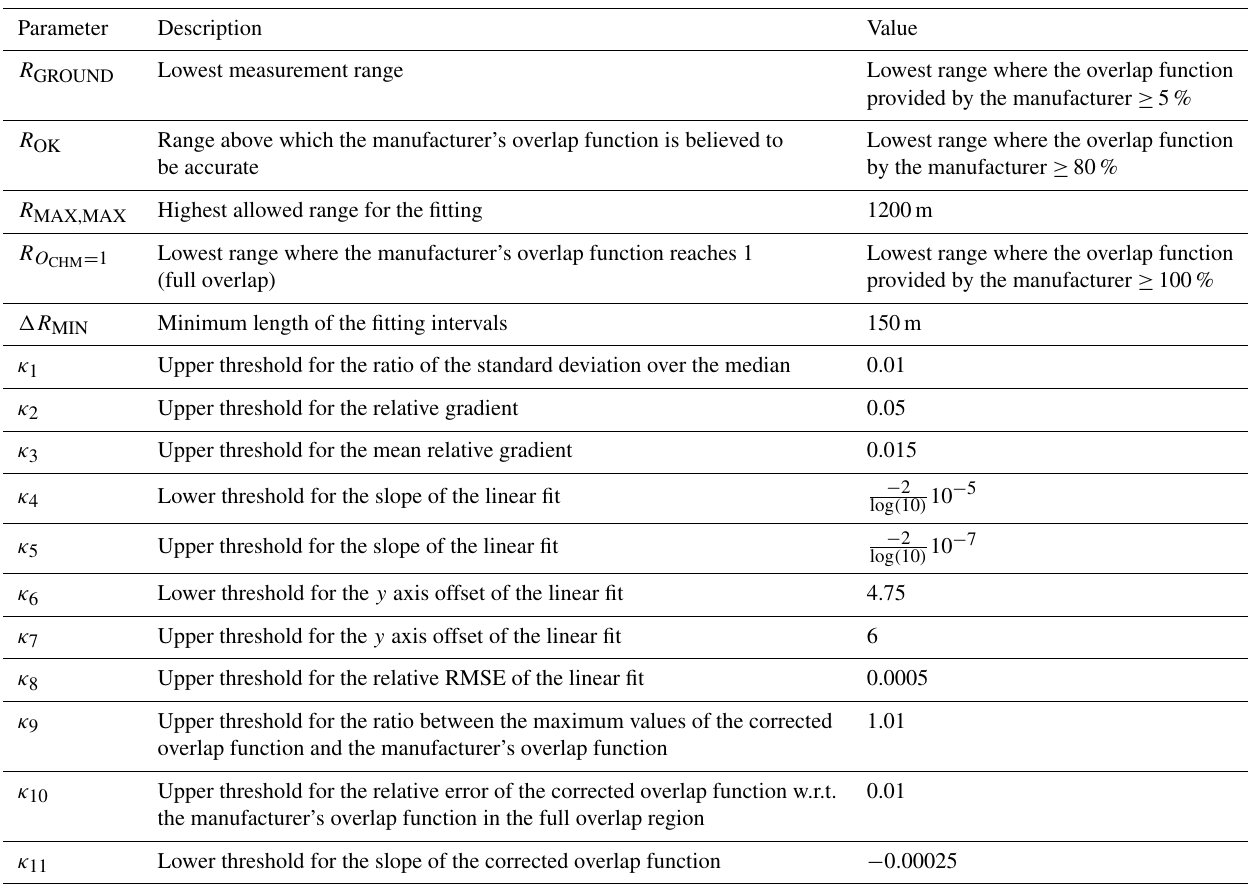
Table A1. Algorithm parameters.